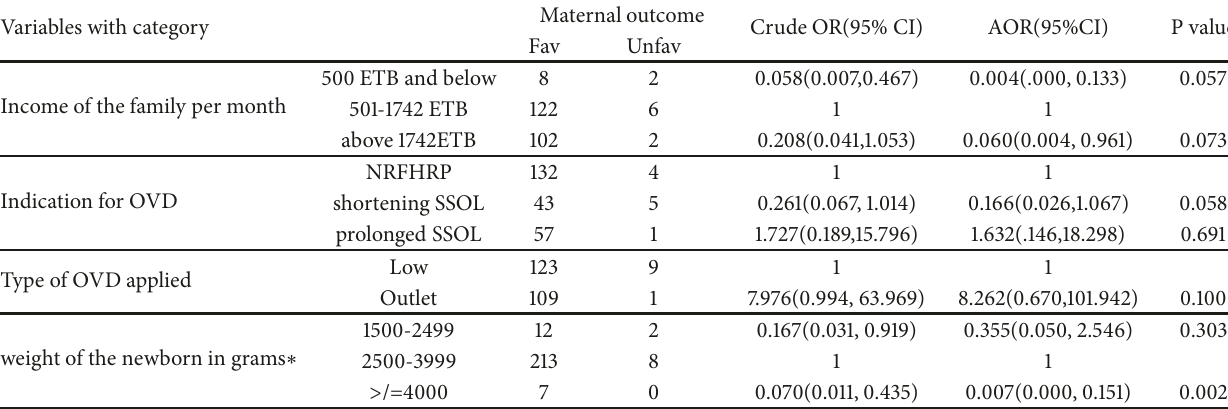
Table 8: Factors affecting maternal outcome using multivariate logistic regression among mothers who gave birth by OVD in